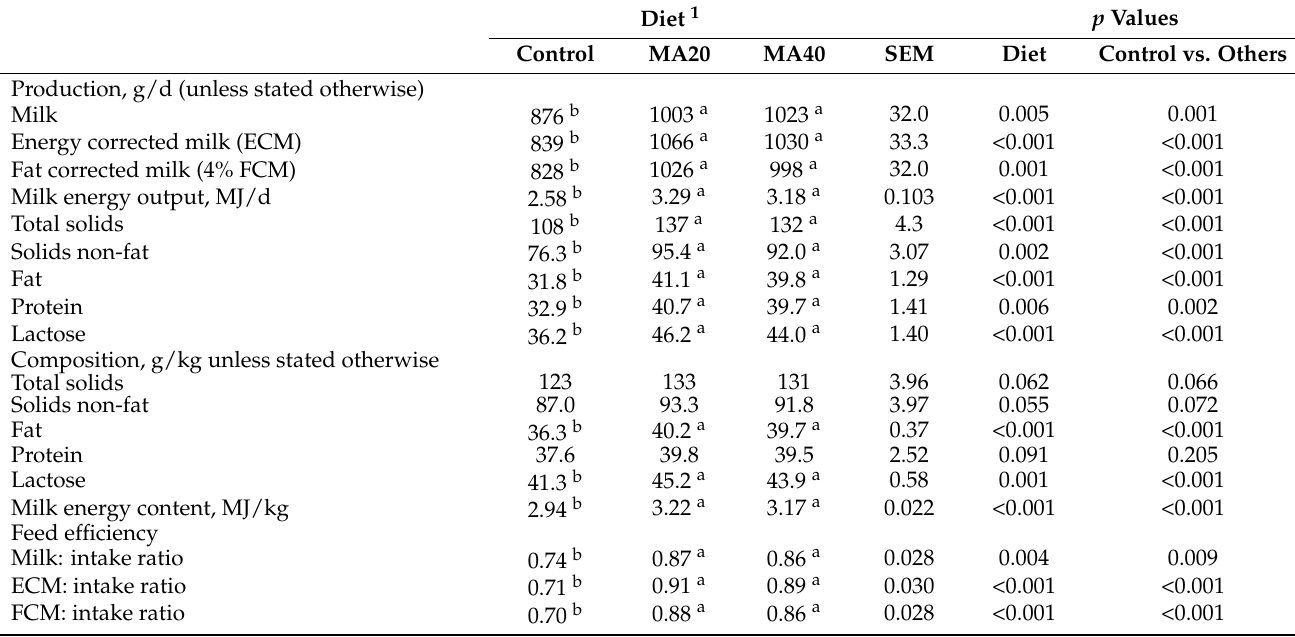
Table 5. Milk yield and composition in lactating Damascus goats fed diets containing Moringa oleifera and Chlorella vulgaris microalgae ( n = 15). Diet 1